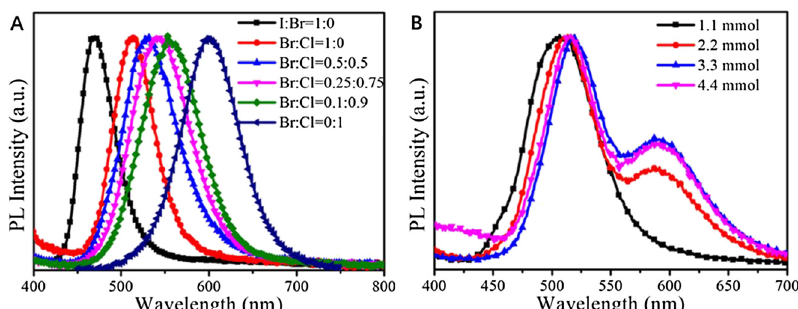
Figure 13: (A) PL spectra of InP/ZnS QDs with different ratios of I, Br, and Cl (B) PL spectra of InP/ZnMnS QDs with varying Mn 2